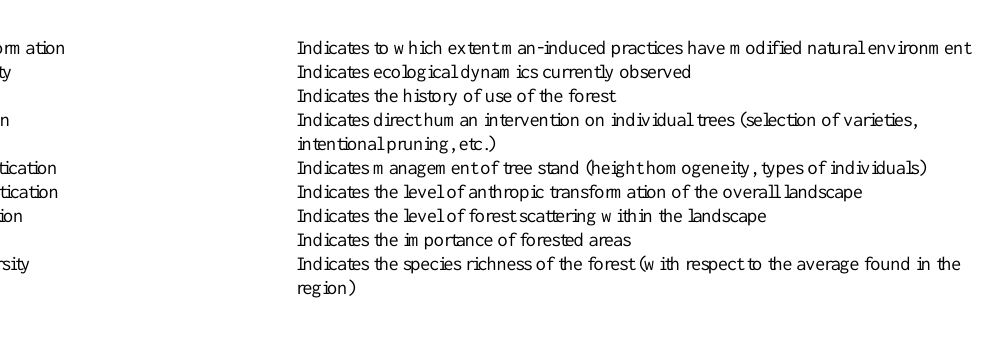
Table 1 . List of the 58 variables conforming the database for characterization of rural forests Ecological characterization Ecosystem